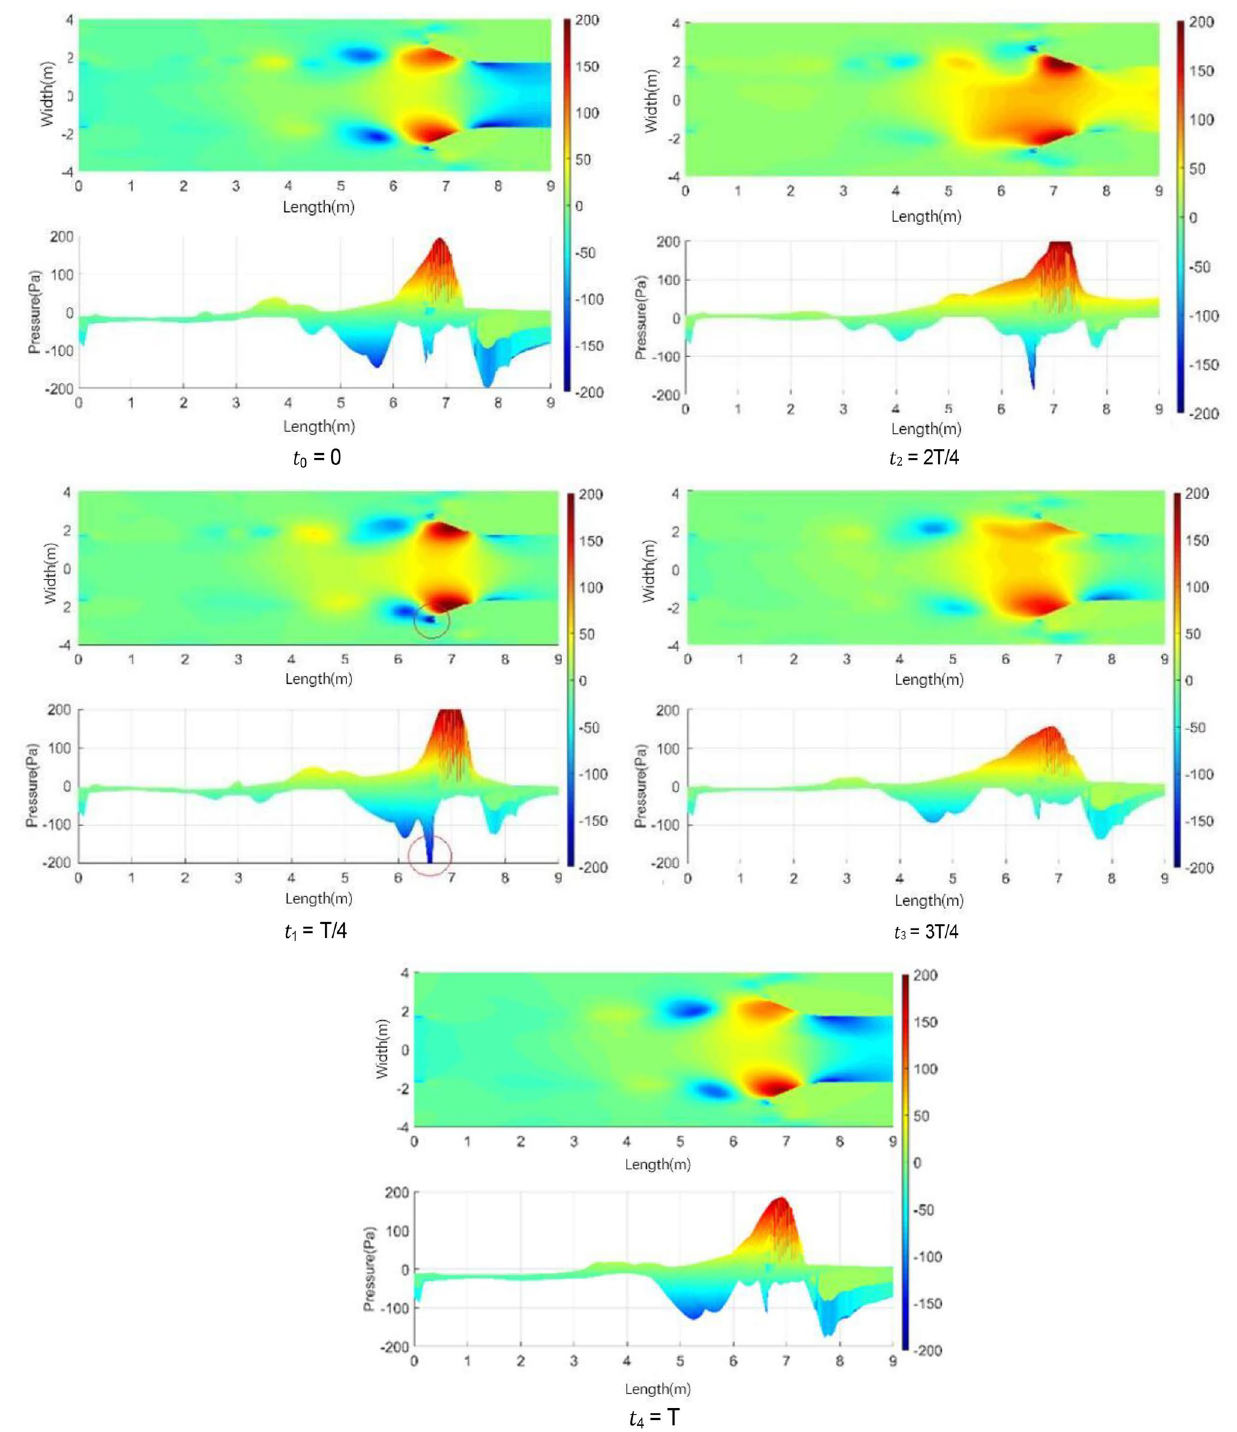
Figure 42. Pressure cloud diagram on the XY central plane of the nozzle flow-follow